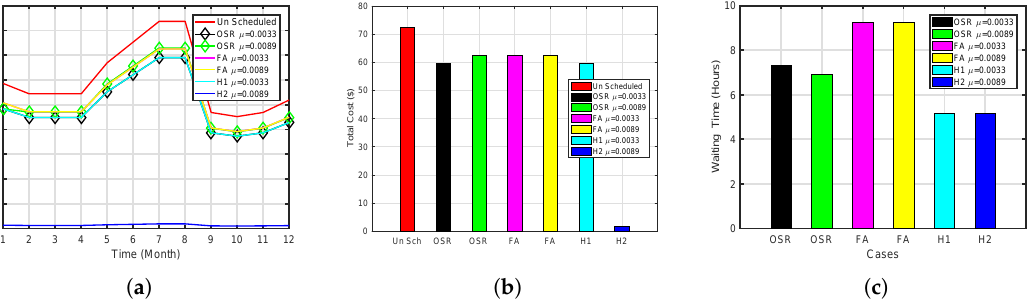
Figure 14. Cont . ( a ) Energy Consumption and Cost of Cloth Dryer, ( b ) Energy Consumption and Cost of Dish Washer, ( c ) Energy Consumption and Cost of